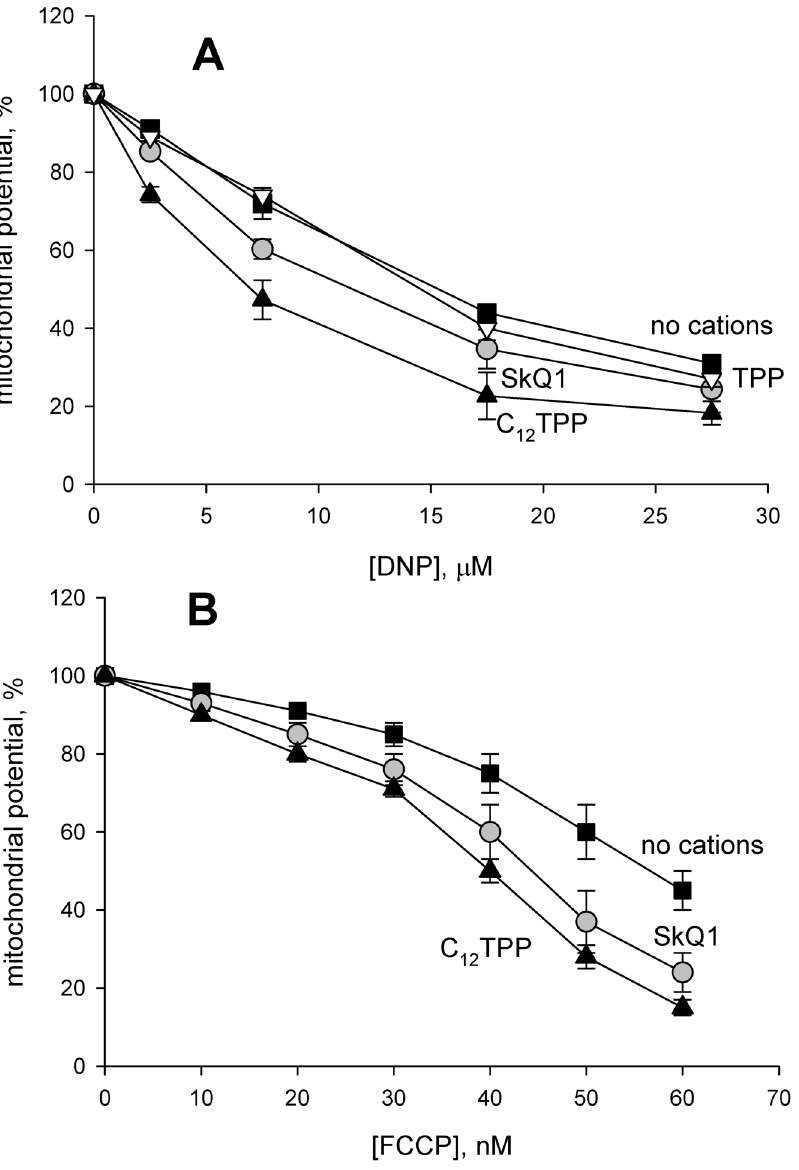
Figure 7. Comparison of SkQ1 and C 12 TPP effects on the uncoupling activity of DNP and FCCP. Effects of 2 m M SkQ1, 2 m M C 12 TPP or 200 m M TPP on the dependence of mitochondrial membrane potential on the concentration of DNP (panel A) or FCCP (panel B). The experiments were conducted in a way shown in Fig. 6. Shown are Mean 6 S.E. of 4–6 experiments.